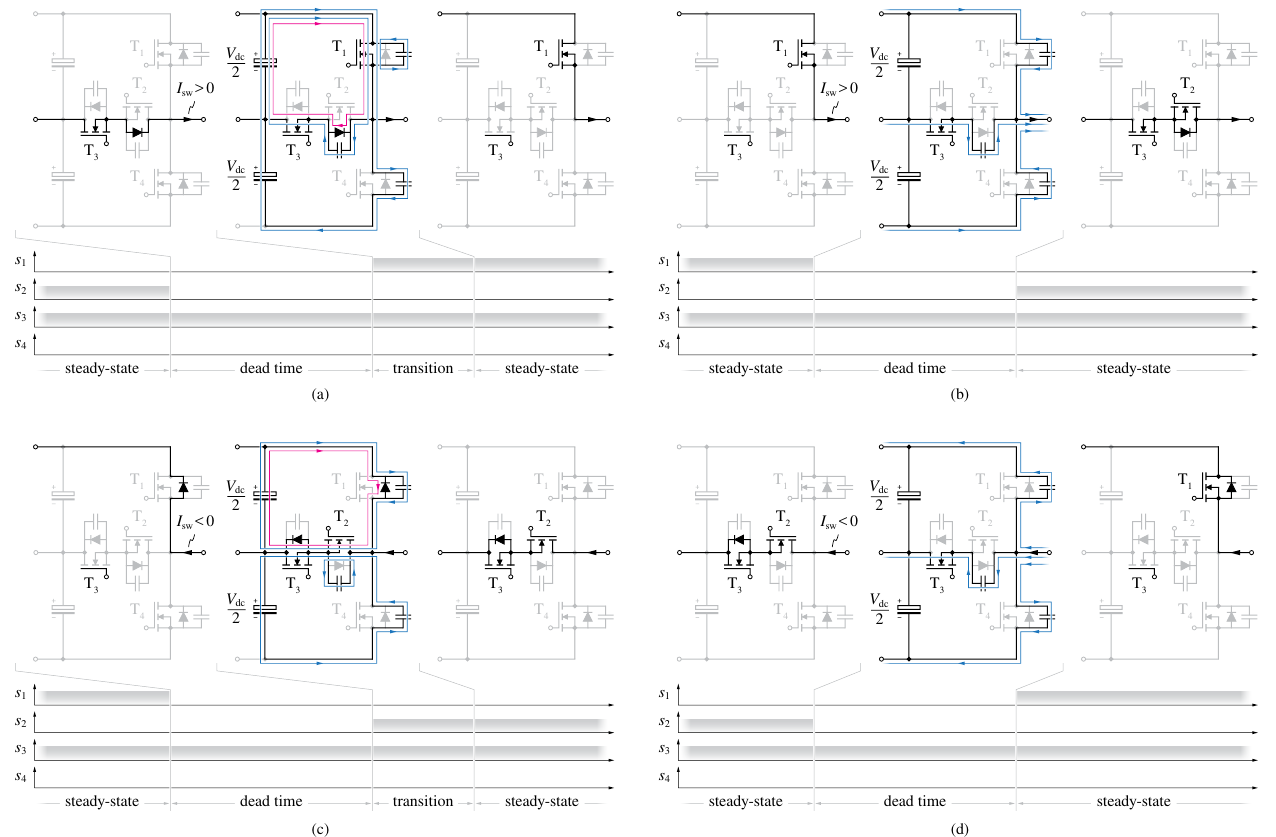
Figure 1. Three-level T-type (3LTT) bridge-leg switching transitions involving T 1 and T 2 . Four different events are identified, depending on the switching sequence T 1 ↔ T 2 and the direction of the bridge-leg output current I sw . ( a ) T 1 ← T 2 , I sw > 0 (hard-switching event), ( b ) T 1 → T 2 , I sw > 0 (soft-switching event), ( c ) T 1 → T 2 , I sw < 0 (hard-switching event), ( d ) T 1 ← T 2 , I sw < 0 (soft-switching event). Blue lines represent the charge/discharge current paths of the semiconductor output capacitances, whereas pink lines indicate the diode reverse-recovery current path. The gate signals of T 1 , T 2 , T 3 , and T 4 are qualitatively shown as s 1 , s 2 , s 3 , and s 4 , respectively, and the steady-state, dead time, and transition intervals are